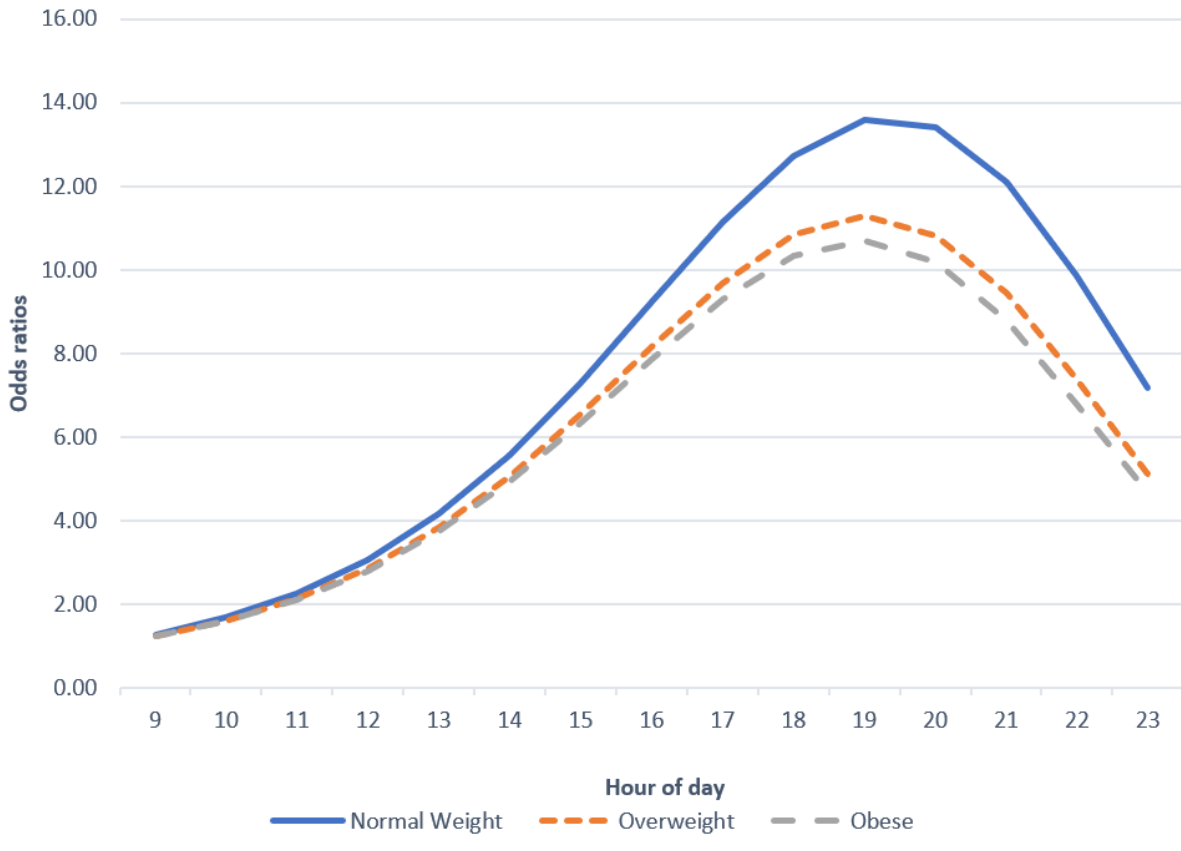
Ortega & CushingJMIR MHEALTH AND